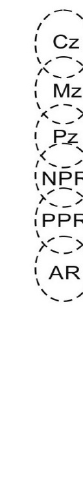
Figure 9. The average levels of exhumation of orogenic gold deposits of different ages.